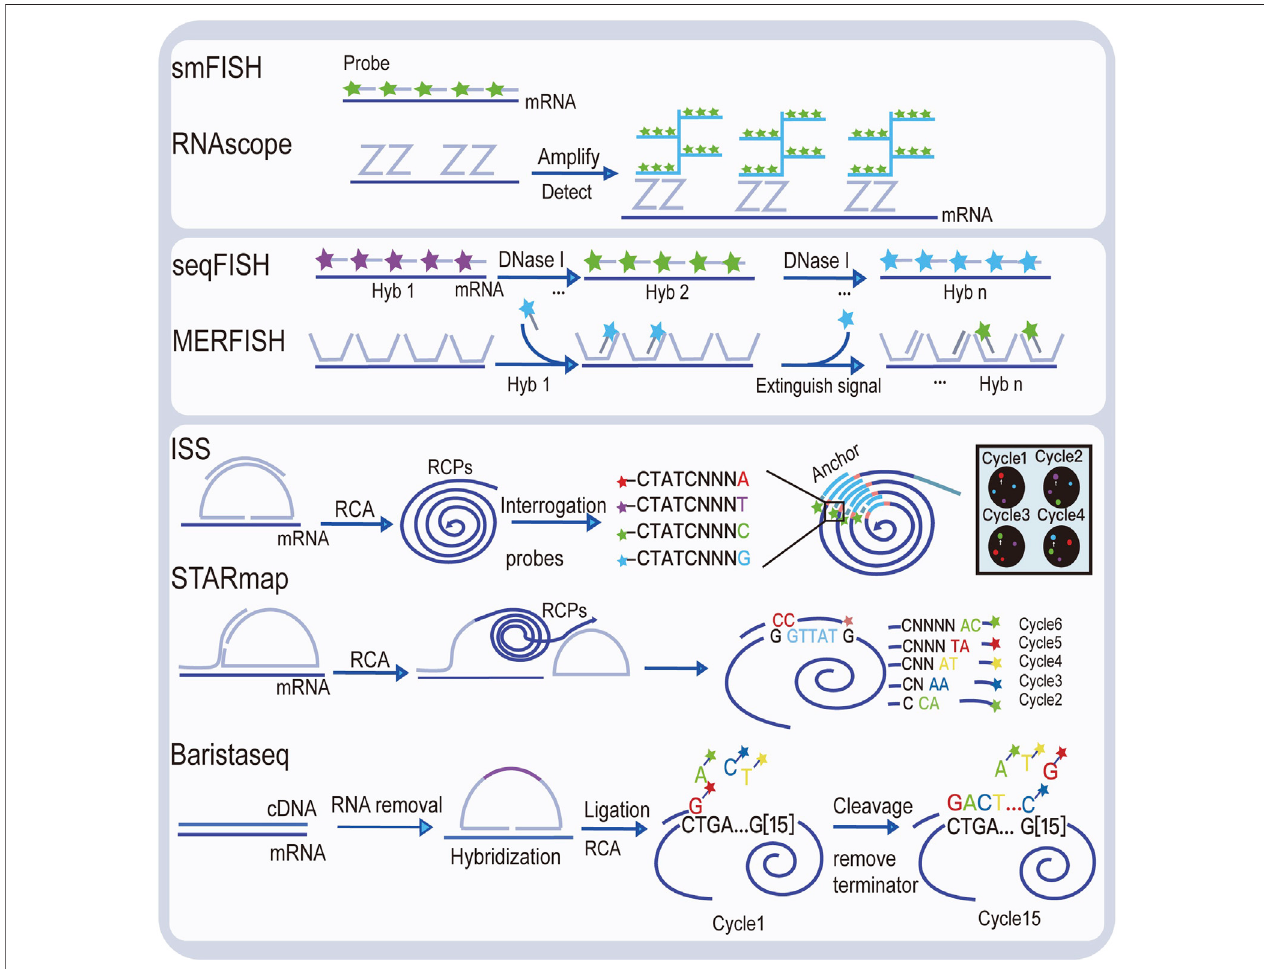
FIGURE 2 | Illustration of image-based spatial transcriptomic